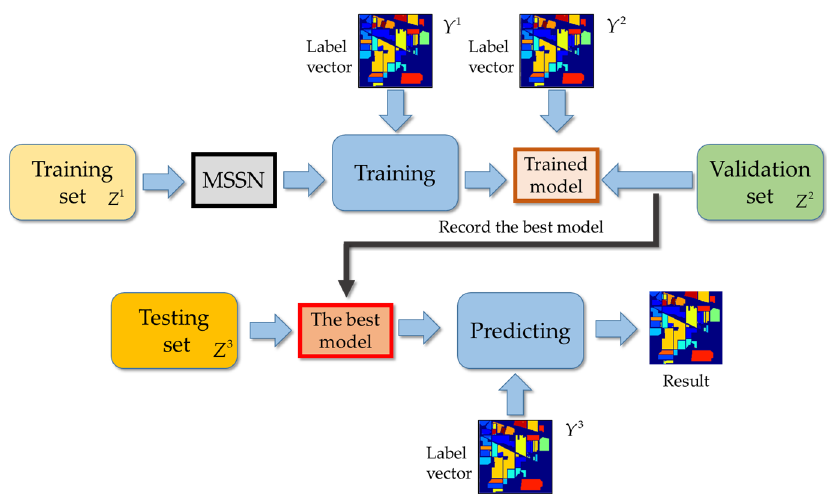
Figure 1. The flow chart of the multi-scale and multi-level spectral-spatial feature fusion network (MSSN) dealing with hyperspectral image (HSI) classification.